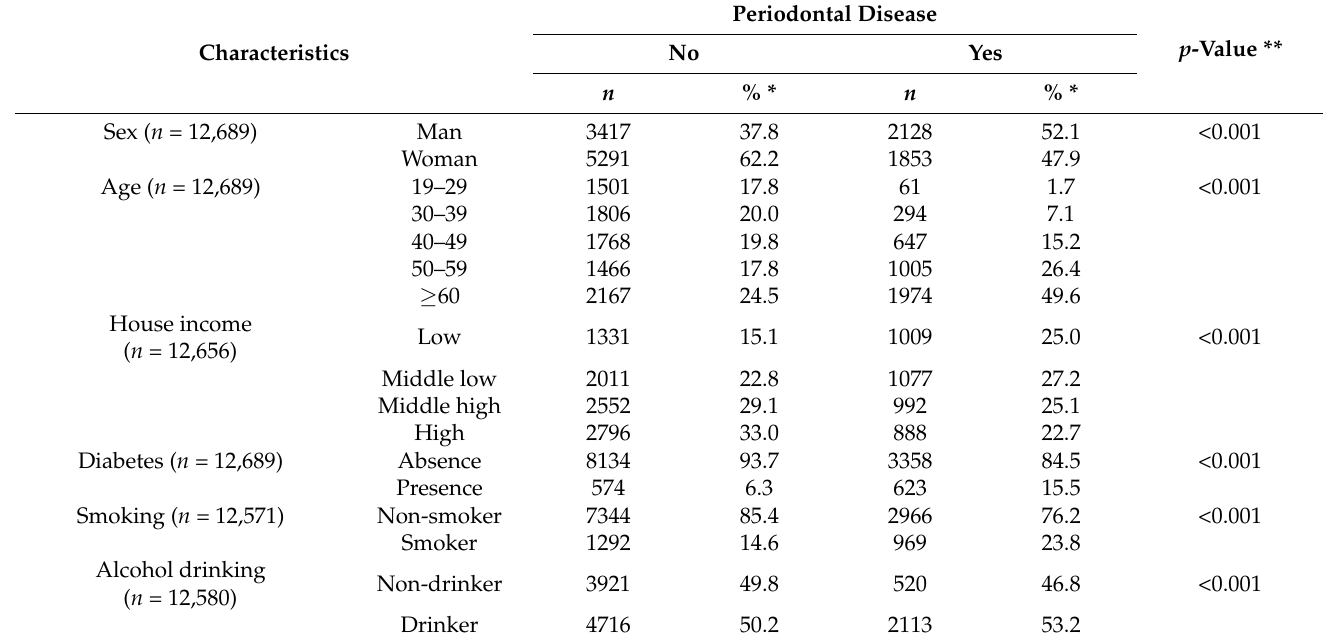
Table 1. Characteristics of the study population stratified by periodontal diseases.